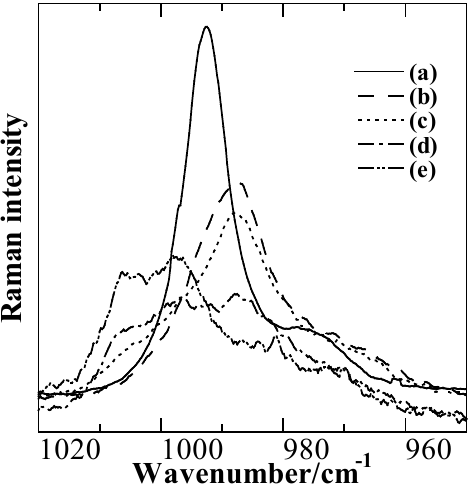
Figure 4. Raman spectra of a 100 mM W(VI)–200 mM As(V)–pH 2.0 system containing various concentrations of V(V) collected after each solution was heated at 80 °C for one week. [V(V)]/mM = (a) 0; (b) 5; (c) 10; (d) 15; and (e)